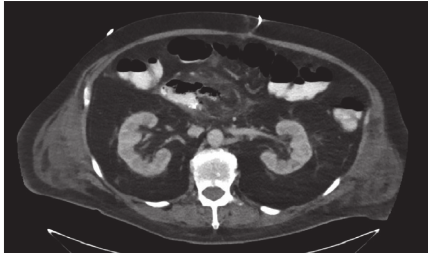
Figure 12: Follow-up CT scan showing resolution of anastomotic